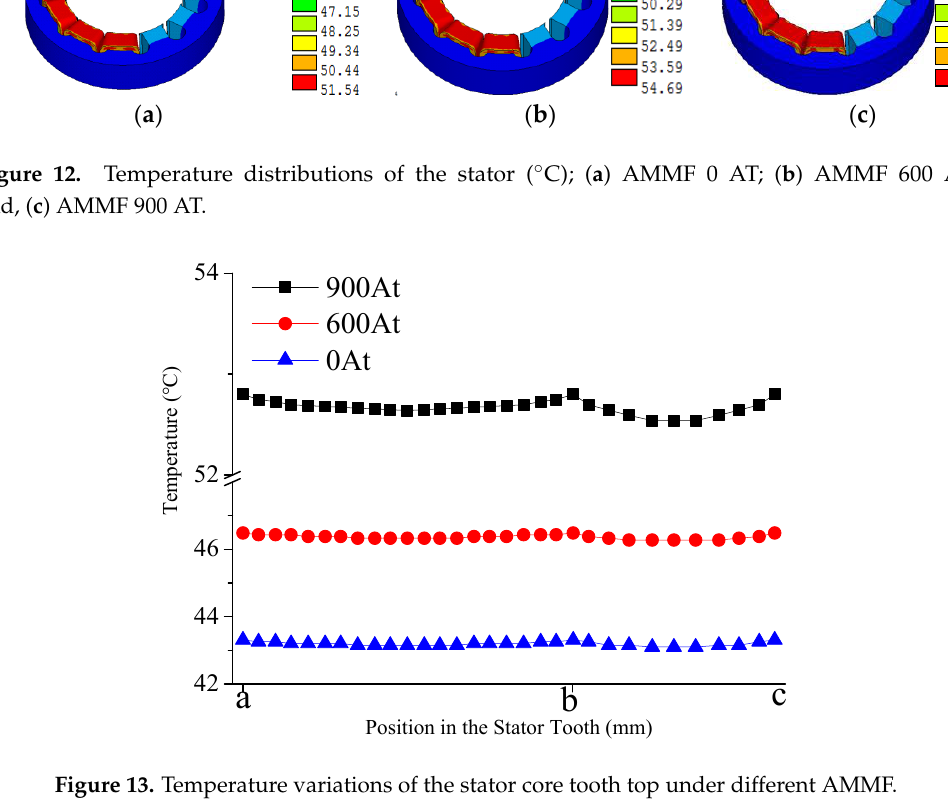
Figure 13. Temperature variations of the stator core tooth top under different AMMF.